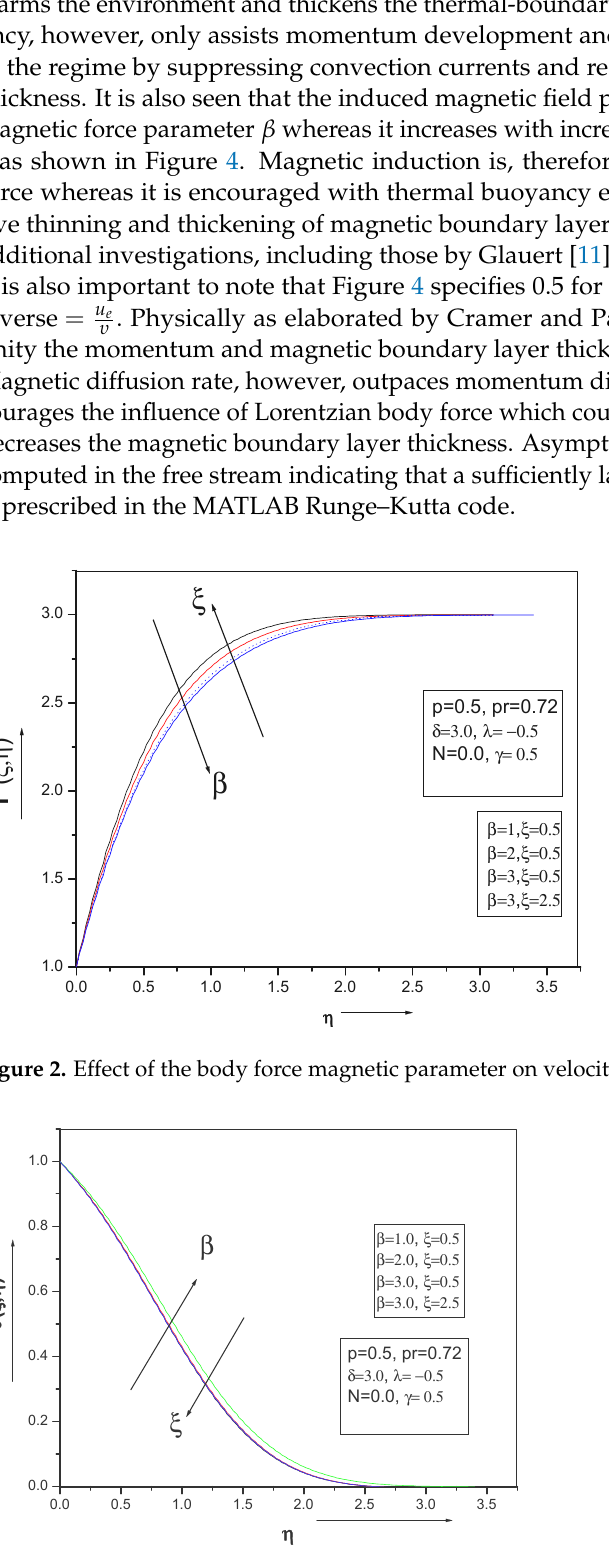
Figure 4. Effect of the magnetic force parameter η on magnetic field profile.